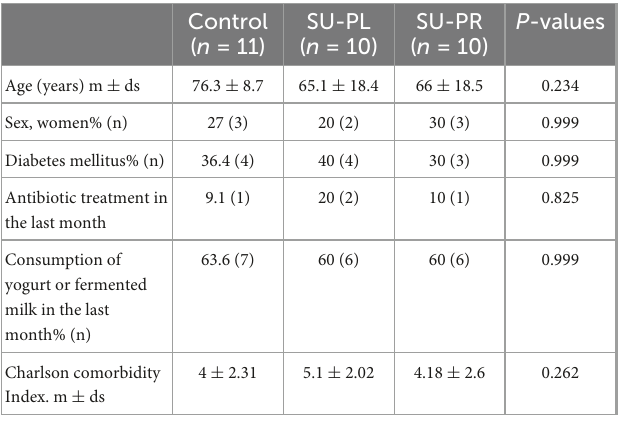
TABLE 2 Baseline characteristics according to the intervention